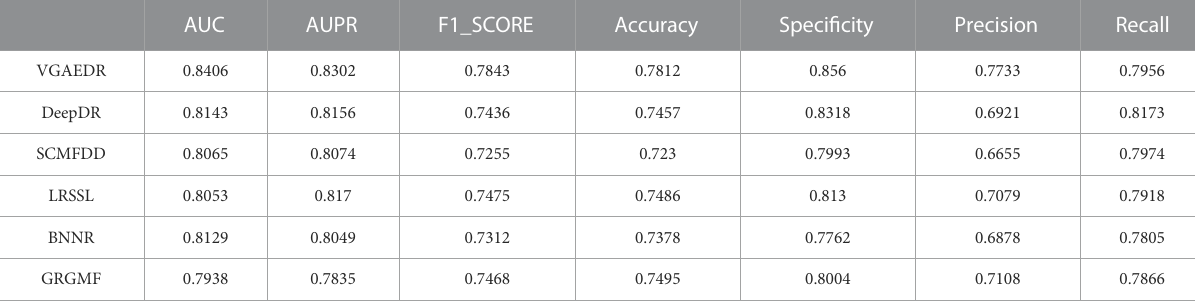
TABLE 4 Performance of comparison method on